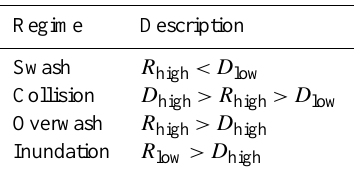
Table 1. Storm impact scale regimes (Sallenger, 2000; Stockdon et al., 2007).